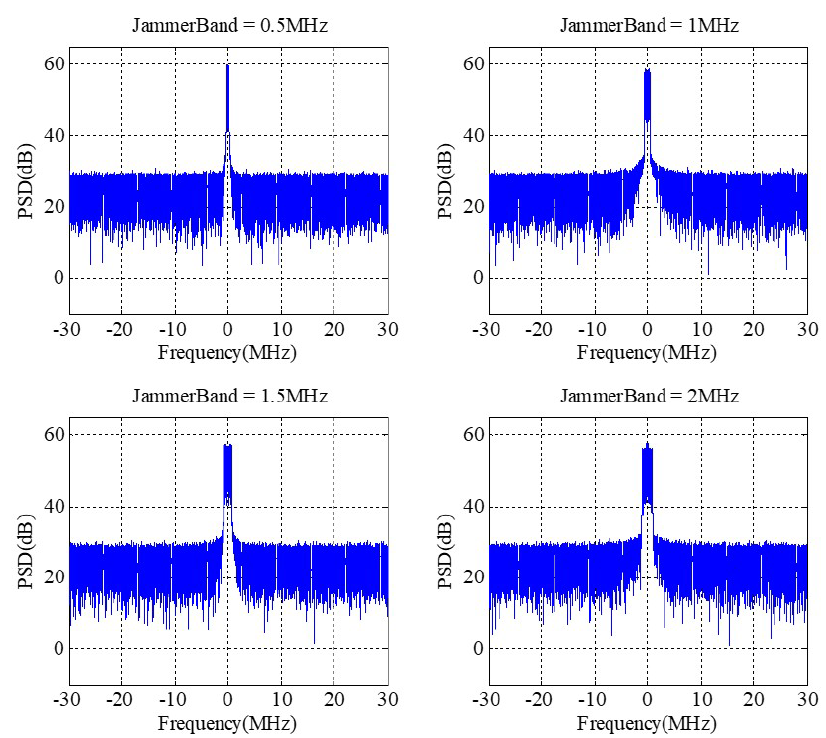
Figure 14. Spectral characteristics before anti-jamming in difference interference bandwidths.